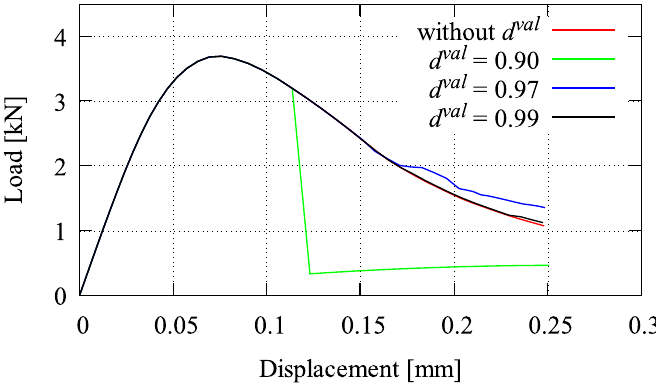
Figure 4. Load-displacement relations for different damage values d val in four-point bending test.